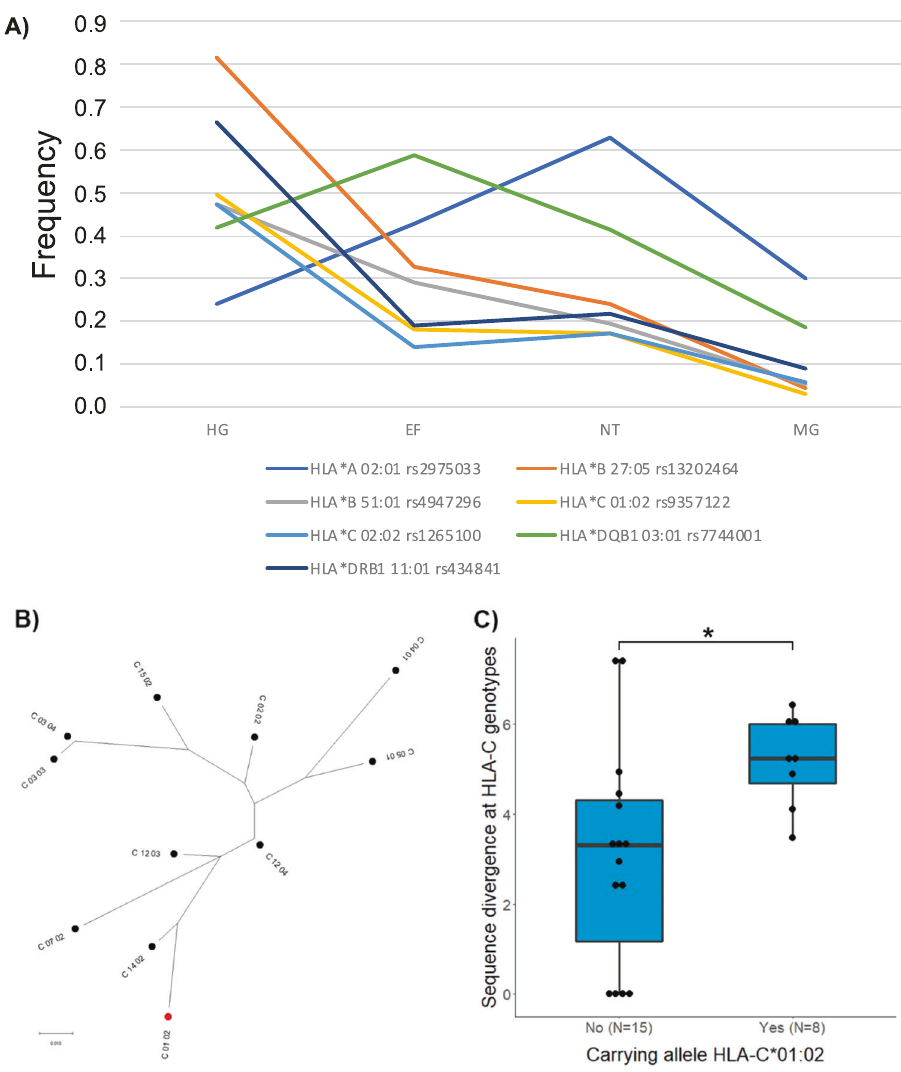
Fig. 3 Analysis of HLA alleles. A Frequency changes of seven HLA alleles over time. Proxy SNPs were used to determine the frequency in 140 hunter – gatherers (HG) and 455 early farmers (EF) 25 . The frequencies for the Niedertiefenbach (NT) population are based on sequencing of the HLA region. HLA frequencies of modern German individuals (MG) were imputed using standard methods 76 (Supplementary Data 4). B Phylogenetic relationship of the 11 HLA-C alleles observed among the Niedertiefenbach individuals. Maximum-likelihood tree based on amino acid sequence (HLA-C*01:02 marked in red). C Comparison of HLA-C amino acid allele divergence between Niedertiefenbach individuals with and without the allele HLA-C*01:02 (* P <